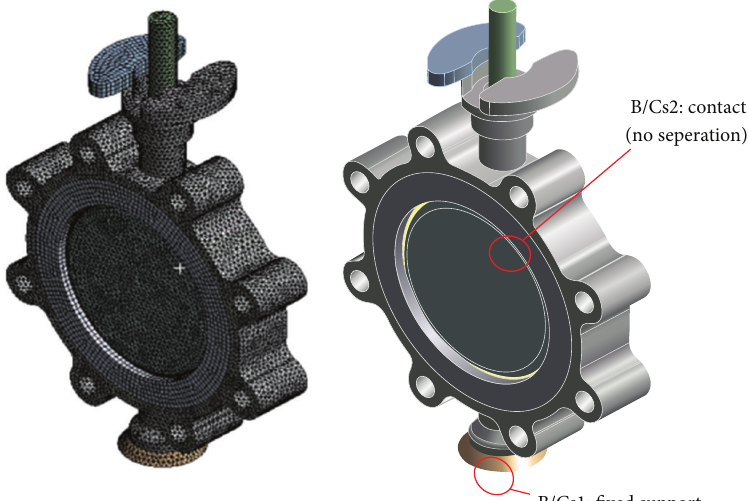
Figure 3: Finite element model and boundary conditions for modal analysis based on static analysis.